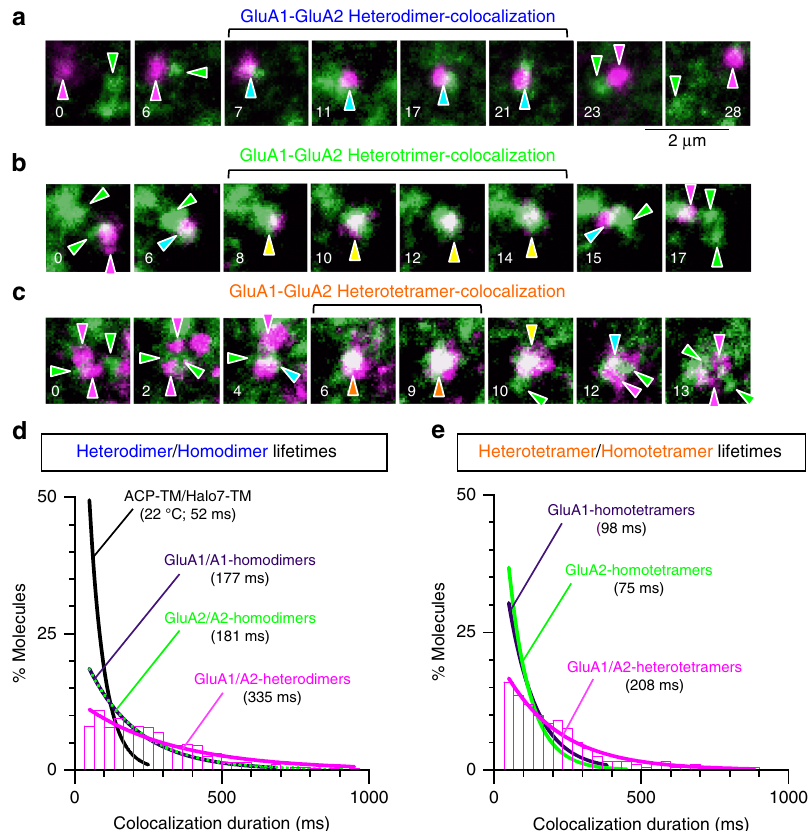
Fig. 4 Heteromer lifetimes are longer than those of homomers. Typical single fl uorescent-molecule image sequences, showing that ACP-GluA1 (magenta spots) and Halo7-GluA2 (green spots) form transient heterodimers ( a ), heterotrimers ( b ), and heterotetramers ( c ) in the HEK293-PM (typical results from 128 or more independent movies, respectively). Magenta and green arrowheads indicate ACP-GluA1 and Halo7-GluA2 monomers, respectively, cyan arrowheads indicate heterodimers, yellow arrowheads show heterotrimers ( b, c ), and orange arrowheads indicate heterotetramers ( c ). d The distribution of the durations of GluA1 – GluA2-heterodimers (magenta), shown together with those of homodimers of GluA1 – GluA1, GluA2 – GluA2, and TM – TM, obtained by simultaneous two-color imaging using ACP- and Halo7-tags. Here, the colocalizations of a protein of interest using different tag proteins (ACP and Halo7 proteins) are called homo (rather than hetero)-dimers, trimers, and tetramers because ACP and Halo7 by themselves did not exhibit any sign of homo and hetero interactions 39 , and in two-color experiments, only homodimers of different colors were included in the colocaization duration histograms. Each histogram could be fi tted as those in Fig. 3d, e. Since virtually the same lifetimes were obtained from the histograms for GluA1 – GluA2 heterodimers (and heterotetramers in e ) when the tag proteins were exchanged (Supplementary Fig. 9c, d), the two histograms were averaged in this fi gure (and also in e ). To avoid excessive complexity of the fi gure, only the best- fi t functions are shown without histograms for the homodimers of GluA1 – GluA1 and GluA2 – GluA2 and for the incidental colocalization of ACP-TM and Halo7-TM (see Supplementary Fig. 9a, b for the histograms). The homodimer lifetimes obtained by two-color experiments were virtually the same as those obtained by single-color experiments (Fig. 3d; Supplementary Figs. 5b and 8d, e; Table 1). e The distribution of the durations of heterotetramers, including 1:3, 2:2, and 3:1 GluA1/A2 heterotetramers (any heterotetramers detected with two colors), shown together with those of the homotetramers of GluA1 and GluA2. Note that the distributions for the homotetramers were obtained by single-color experiments. For the duration distributions of homotetramers of GluA1 and GluA2, see Fig. 3e and Supplementary Fig. 8d. For statistical parameters, see Supplementary Table PM of the dendritic shaft (marked by GAP-43-Venus expression) diffused at slower rates than those in the HEK293-PM by a factor of ~1.56. This was determined by using two monomeric reference molecules labeled with fl uorescent tags 39,40 ; Cy3-DOPE, a fl uor- escent (non-raft) phospholipid analog, and Halo7-CD47, a TM protein with fi ve TM domains (Supplementary Fig. 11a; Supple- mentary Table 9).